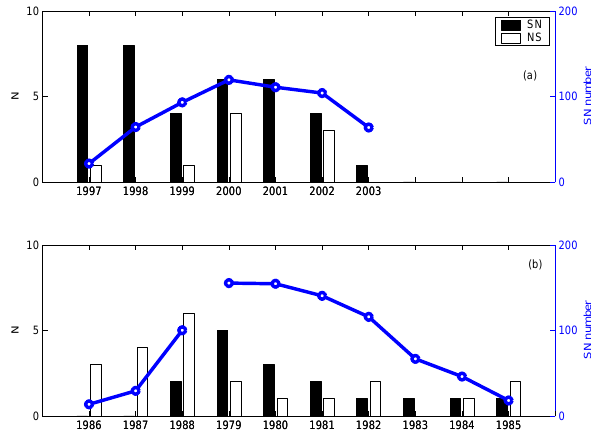
Fig. 5. Yearly number of MCs with magnetic field rotations from the south to the north (black) and from the north to the south (white) in our study ( a ) and in Mulligan et al. (1998) study ( b ) . In (b) the years have been arranged to coincide with the years of approxi- mately the same solar cycle phase in